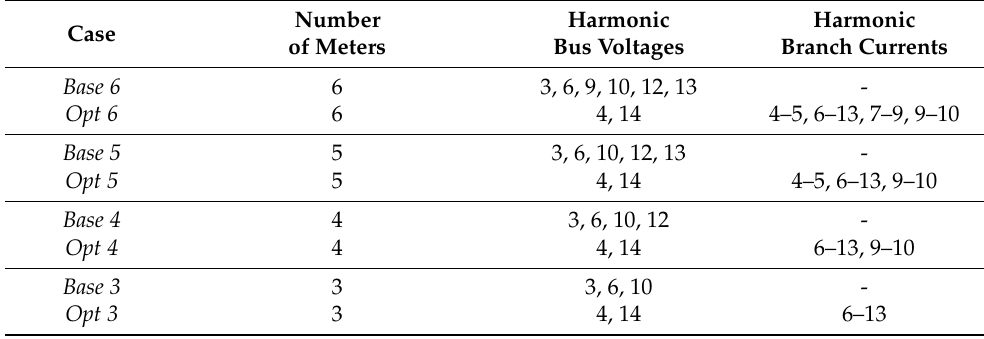
Table 2. Base and optimal harmonic meter placement for different numbers of harmonic measure-